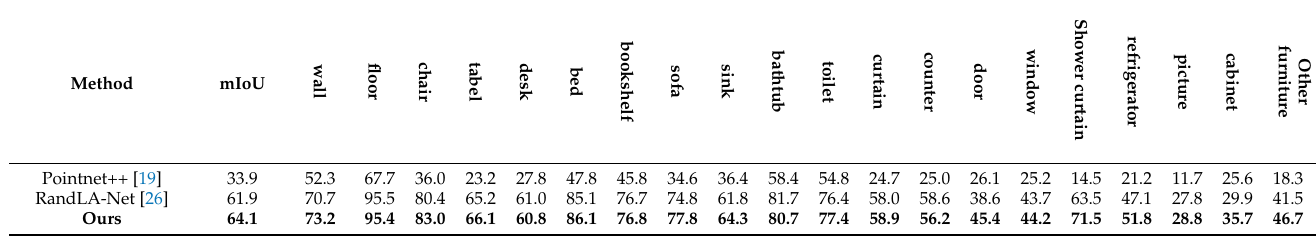
Table 2. Comparison of the semantic segmentation on ScanNet datasets.